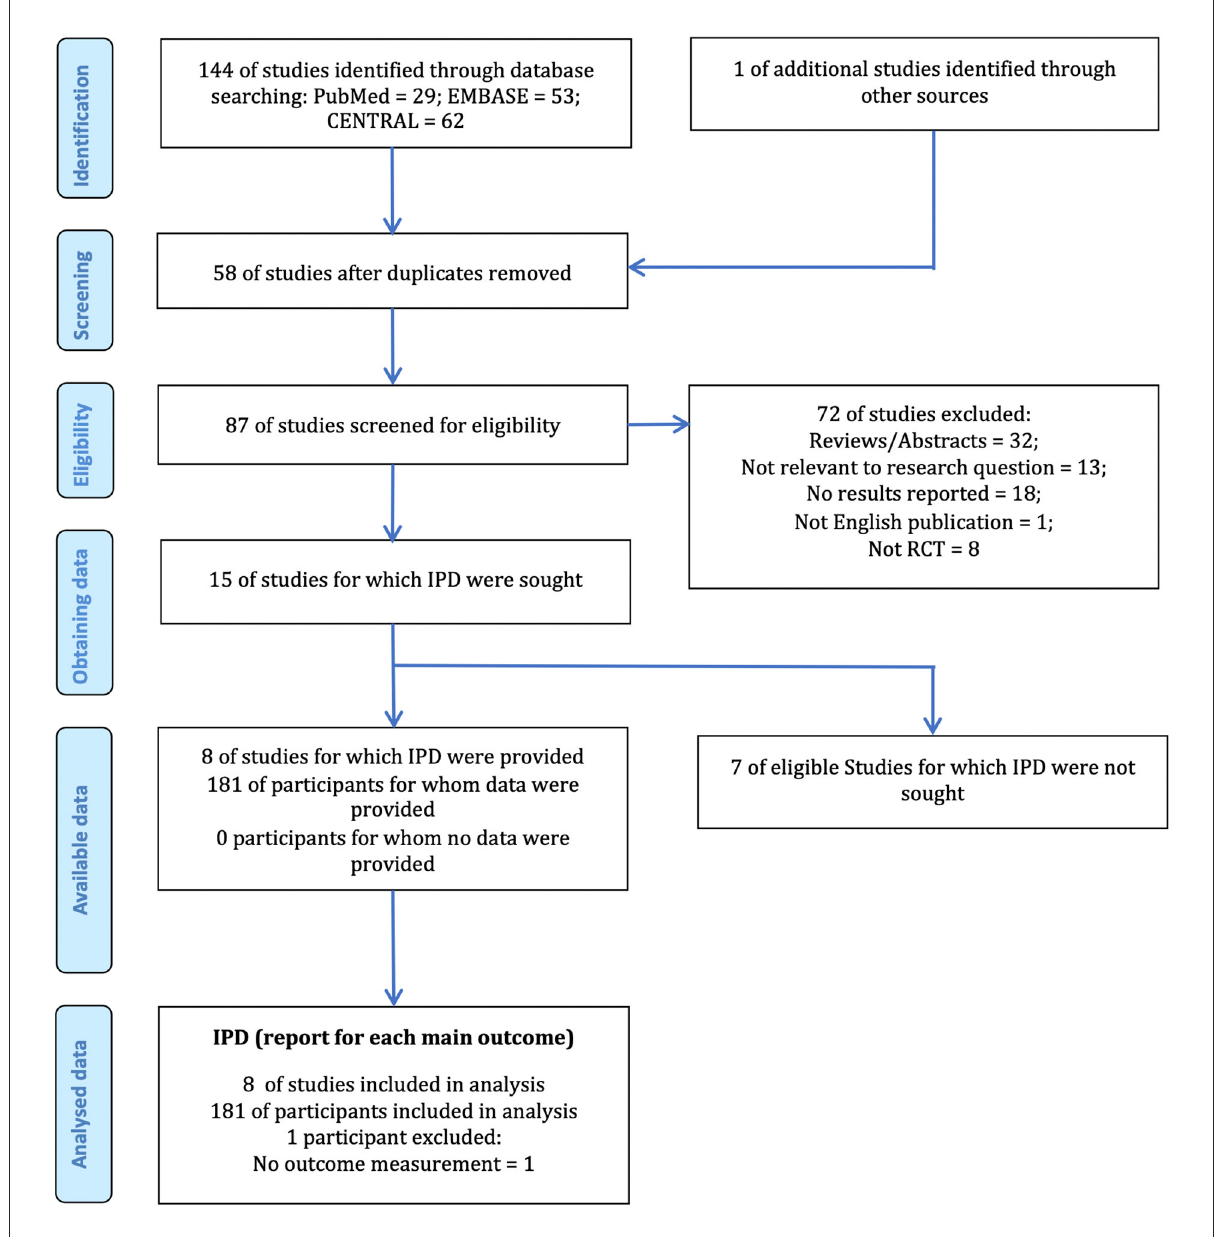
FIGURE1 The PRISMA IPD flow diagram. IPD, Individual Patient Data; RCT, Randomized Clinical Trial; PRISMA, Preferred Reporting Items for Systematic Reviews and